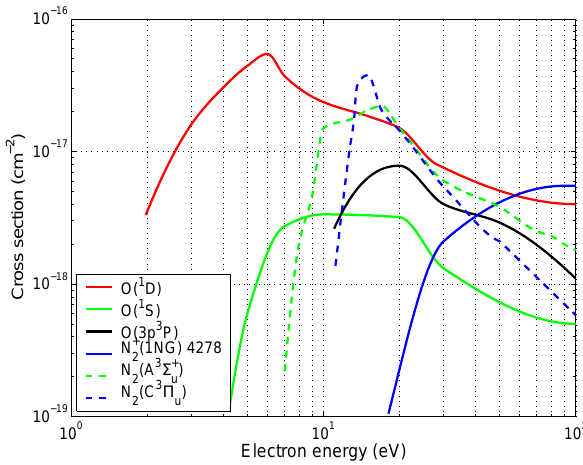
Fig. 4. Cross sections for electron impact excitation of O( 1 D) − emitting at 6300 ˚A, with excitation threshold 1.965eV − experi- mental data from Doering (1992), O( 1 S) − emitting at 5577 ˚A, with excitation threshold 4.19eV − experimental data from Doering and Gulcicek (1989), O( 3 p 3 P) − emitting at 8446 ˚A, with excitation threshold 10.99eV − experimental data from Itikawa and Ichimura (1990). For electron excitation of ( N 2 ) we have the emission cross section for 4278 ˚A from ( N + ) with threshold for ionization + ex- 2 (A 3 6 + u ) and citation at 18eV and excitation cross section for N + 2 N 2 (C 3 5 u ) − all with experimental data from Itikawa et al.